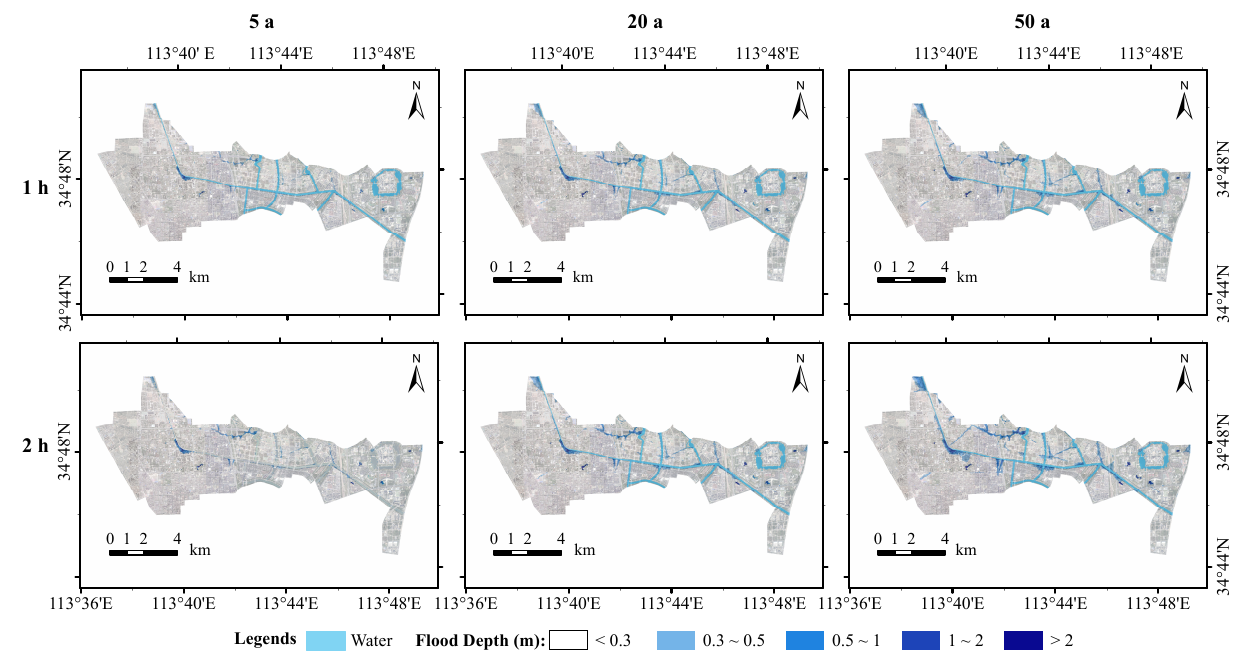
Figure 5. Simulated inundation depth